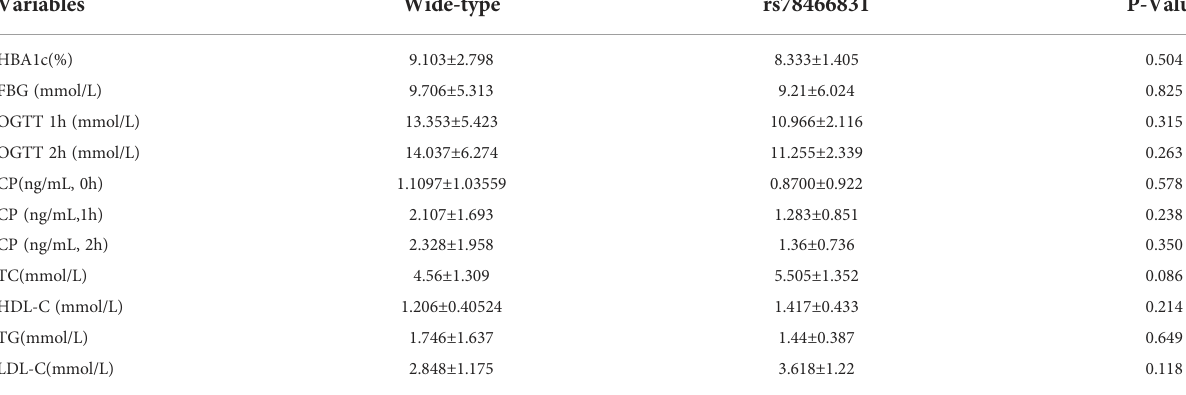
TABLE 3 Clinical laboratory characteristics of the wild-type and rs78466831 patients with T2DM.